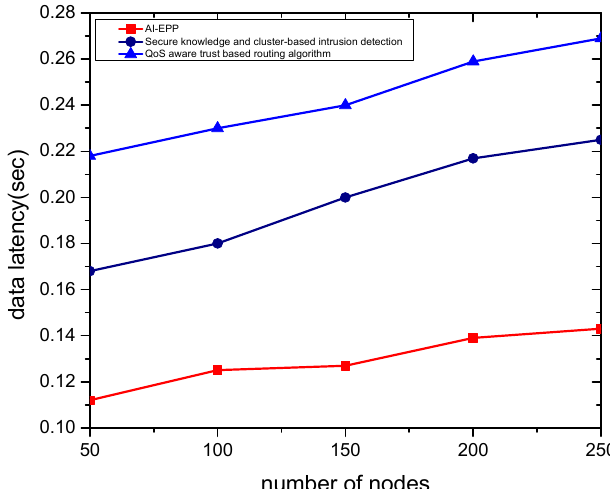
Figure 5. Data latency comparison using simulations with varying number of nodes.